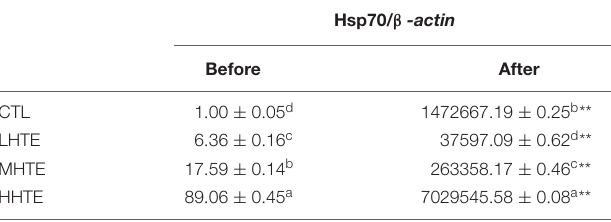
TABLE 2 | The mRNA relative expression levels of heat shock protein 70 (Hsp70) in female flies fed a diet containing low, medium, and high concentrations (LHTE, MHTE, and HHTE, respectively) of hsian-tsao extract (HTE) or a non-HTE control diet (CTL) before and after heat exposure (60 female flies per group, 20 per replicate).